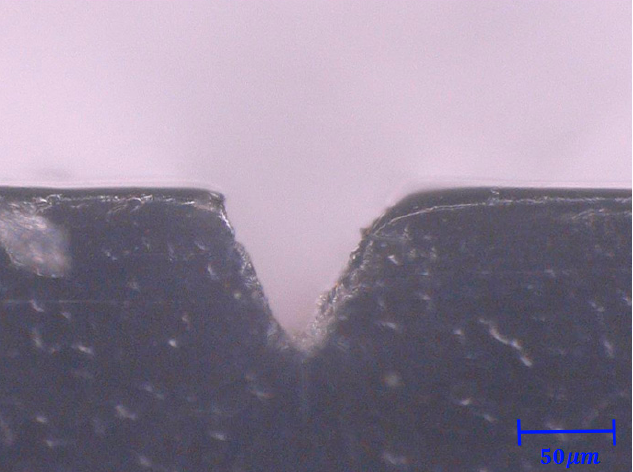
Figure 6. Morphology of single grooves under direct writing with scanning speed of 1 mm/s and average power of 4 W.